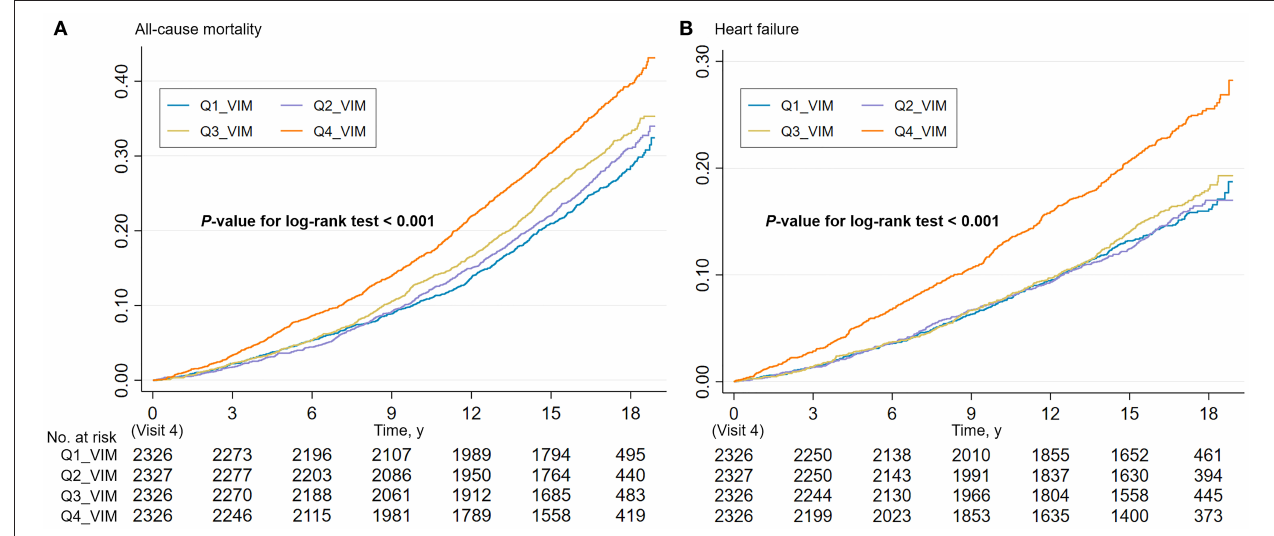
FIGURE 1 | Cumulative incidence estimates (Kaplan–Meier) for the (A) all-cause mortality and (B) heart failure in four groups by quartile value of MAP variability (VIM). MAP, mean arterial pressure; VIM, variability independent of the mean.